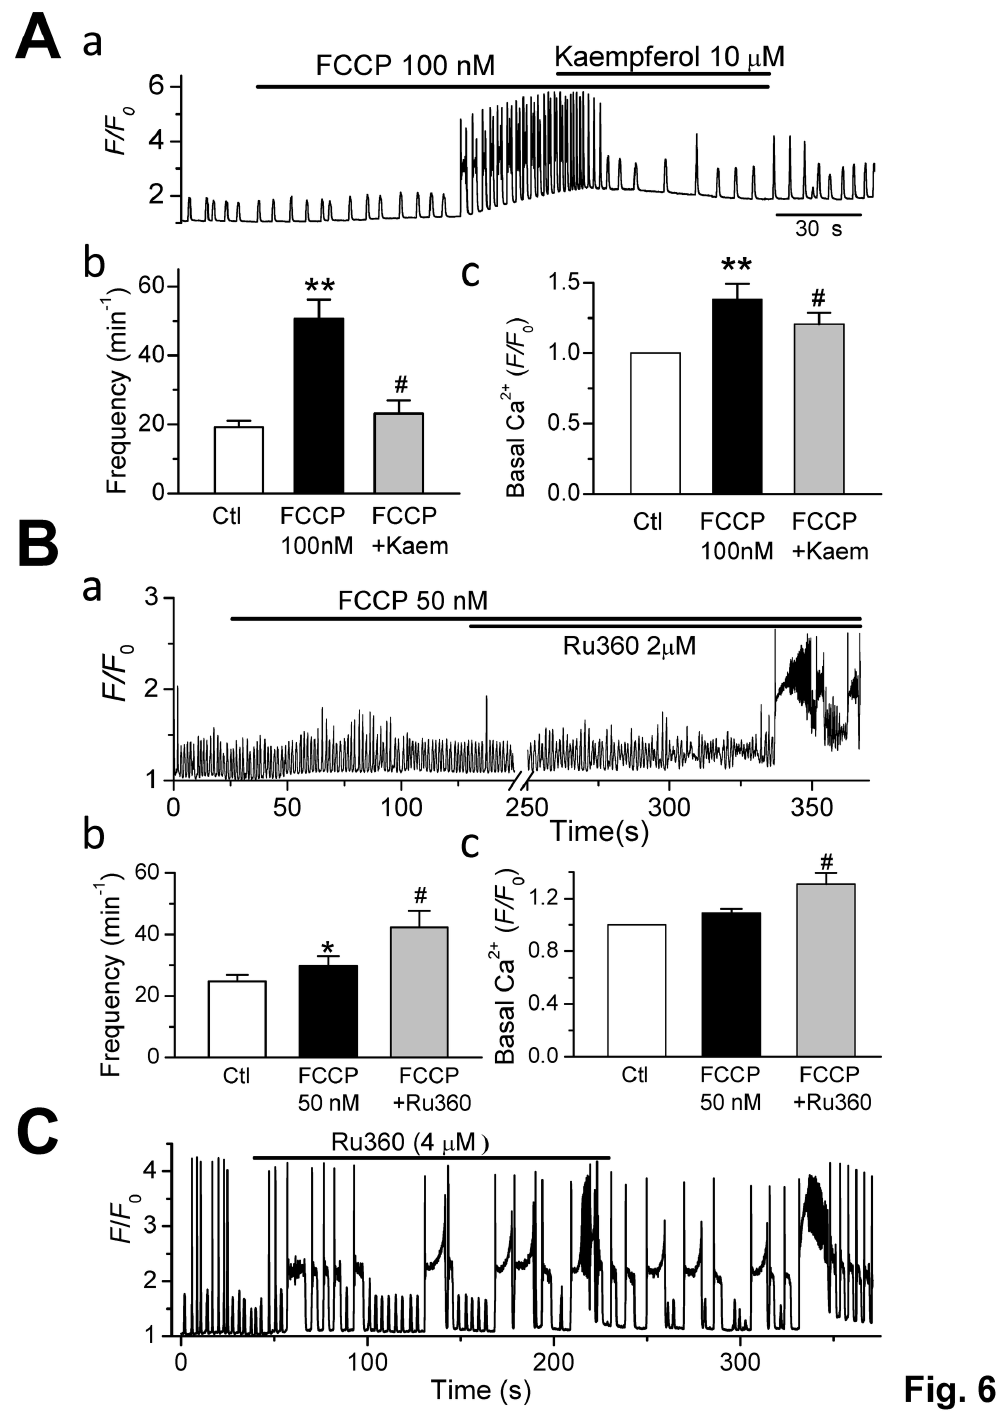
Figure 6. Effect of mCU Ca 2+ flux on CaWs. A . Kaempferol, a mitochondrial uniporter (mCU) opener, significantly attenuated CaWs induced by 100nM FCCP. A representative trace (A- a ) and summarized data for CaW frequency (A- b ) and basal [Ca i2+ ] level ( c ) are shown (** p < 0.01 vs. control; # p < 0.05 vs. FCCP, n = 5). B . The effect of Ru360, a mCU blocker, on CaW frequency and basal [Ca i2+ ] level in the presence of 50 nM FCCP. A representative trace (B- a ) and summarized data (B-b & c) are shown. # p < 0.05 vs. FCCP (n = 5). C . The effect of Ru360 on CaW in the absence of FCCP. Note a persistent and fast oscillating status after Ru360 treatment. doi: 10.1371/journal.pone.0080574.g006 PLOS ONE |